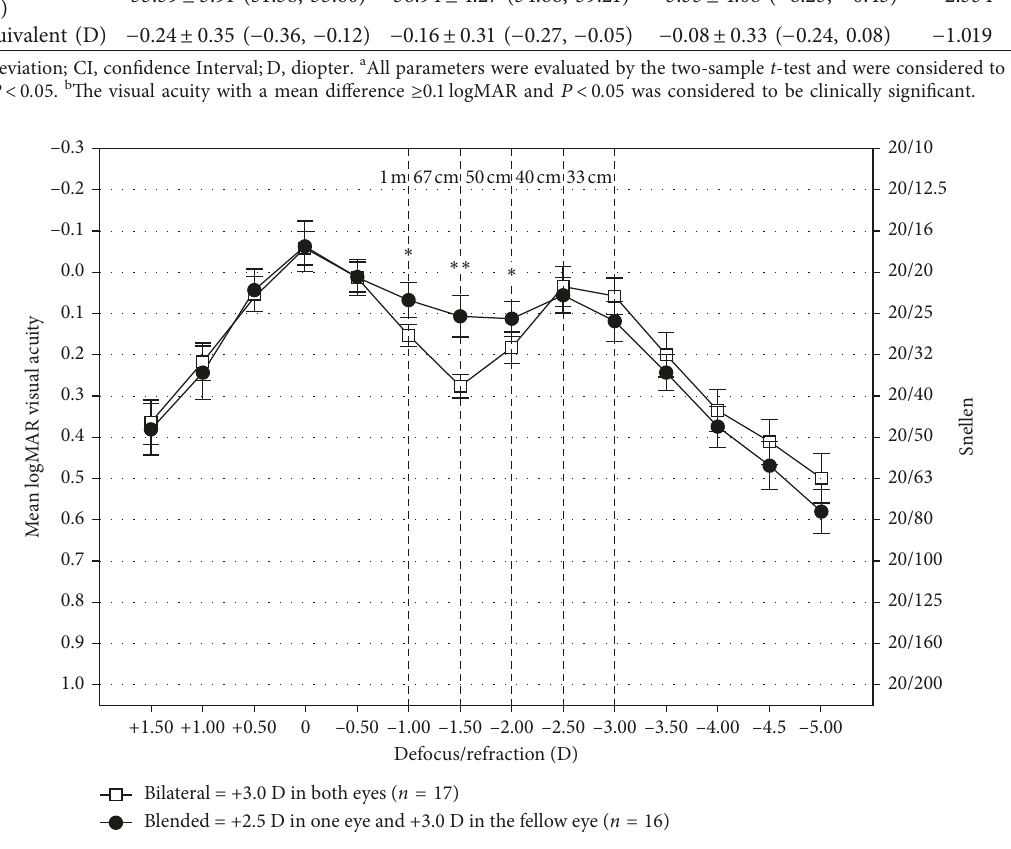
Figure 1: Mean and 95% confidence limits for binocular vision for defocus curves testing (D,